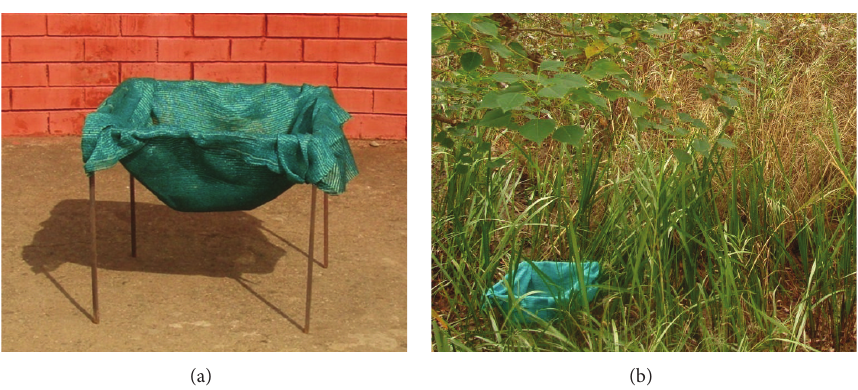
Figure 1: (a) Litter trap of dimension 50 × 50 × 50cm 3 and (b) its placement in the site.